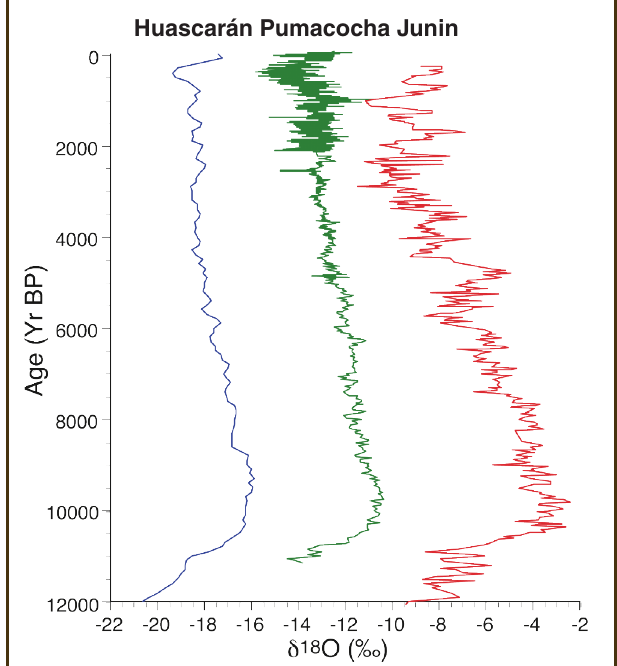
Figure 3. Oxygen isotope records from the central Peruvian Andes: Huascarán Ice Core (Thompson et al., 1995), Laguna Pumacocha (Bird et al., 2011), and Lake Junin (Seltzer et al., 2000 and unpublished data). The age model for the Junin record is based on a combination of radiocarbon and U/Th ages. The steeper Holocene isotope gradient of Junin reflects the hydrologically-closed nature of Junin, which makes Junin especially sensitive to changes in regional hydrologic